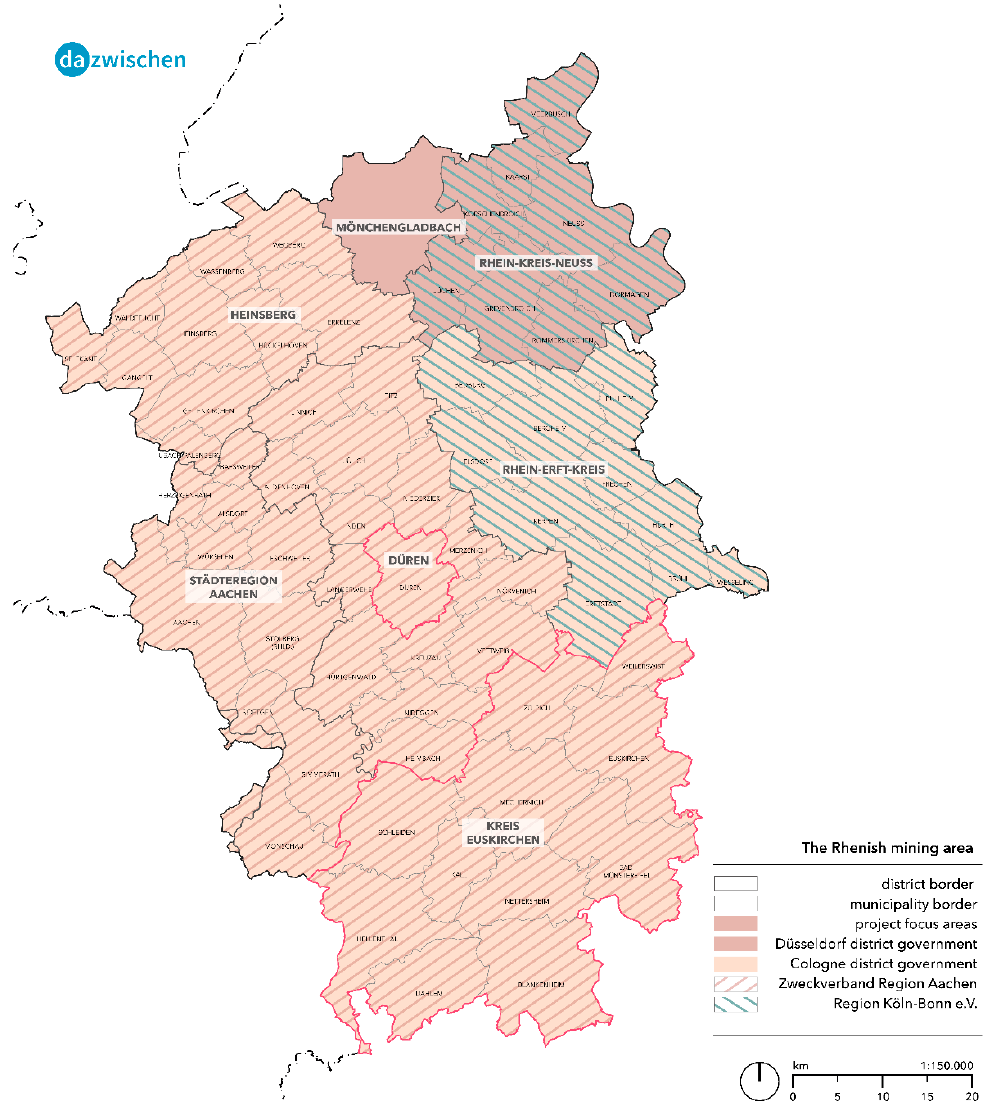
Figure 7. Political and association-based bodies in the Rhenish coal-mining area. Source: own Fig- ure.